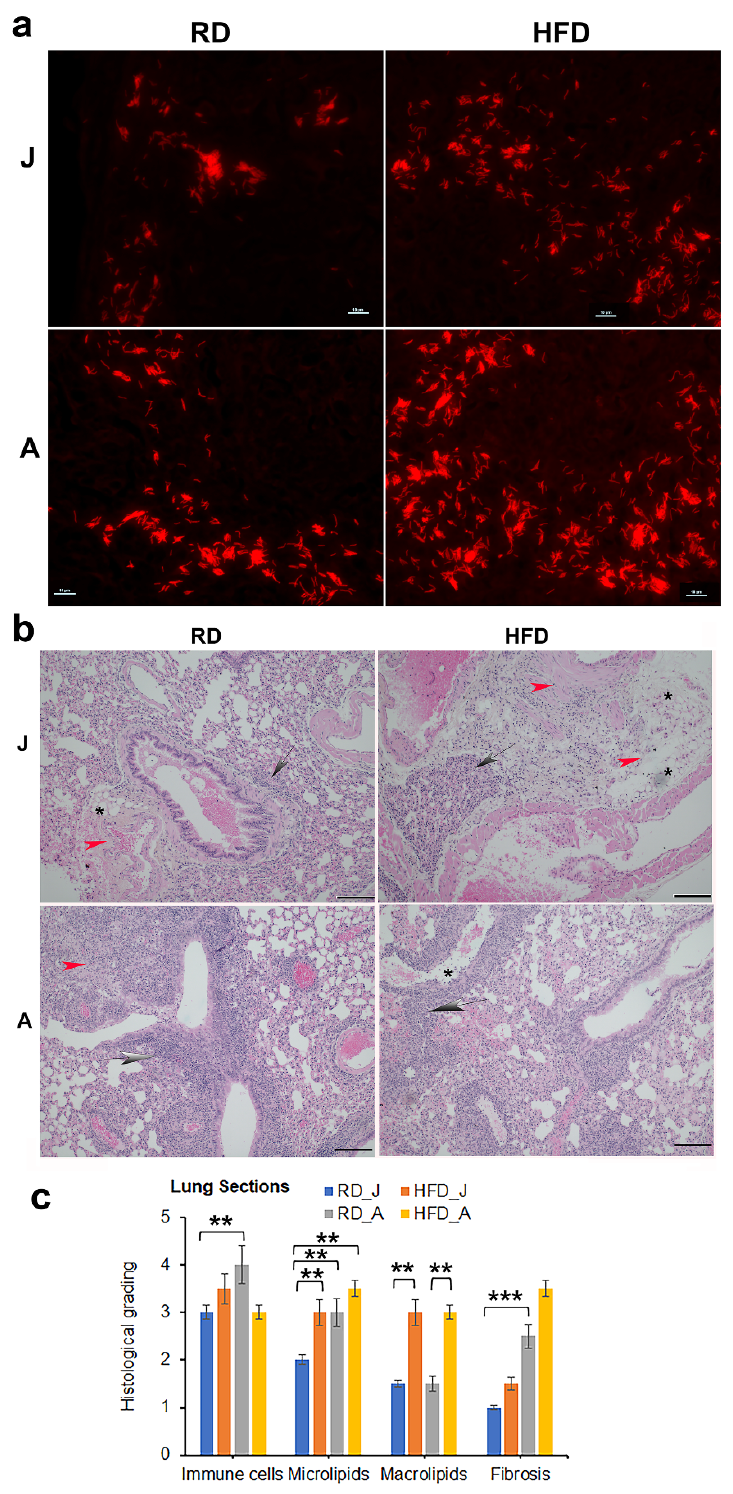
Figure 2. Diets differently regulate Mtb load in the lungs in juvenile and adult mice (30 DPI, n = 5/group). ( a ) Auramine-rhodamine (AR) staining (fluorescent red rods) demonstrated the presence of Mtb in the lung sections of H37Rv infected juvenile and adult mice (×40 magnification). ( b ) Histological analysis of the lungs demonstrated increased lung pathology (infiltrated immune cells [grey arrows]) and decreased alveolar space in Mtb -infected adult mice compared to juvenile mice fed a RD or HFD. The presence of lipid droplets [black stars] and fibrosis [red arrowhead] are shown in the images (×20 magnification, scale bar = 100 um. ( c ) Histological grading of lung pathology was carried out according to experimental groups and classified in terms of infiltrated immune cells,